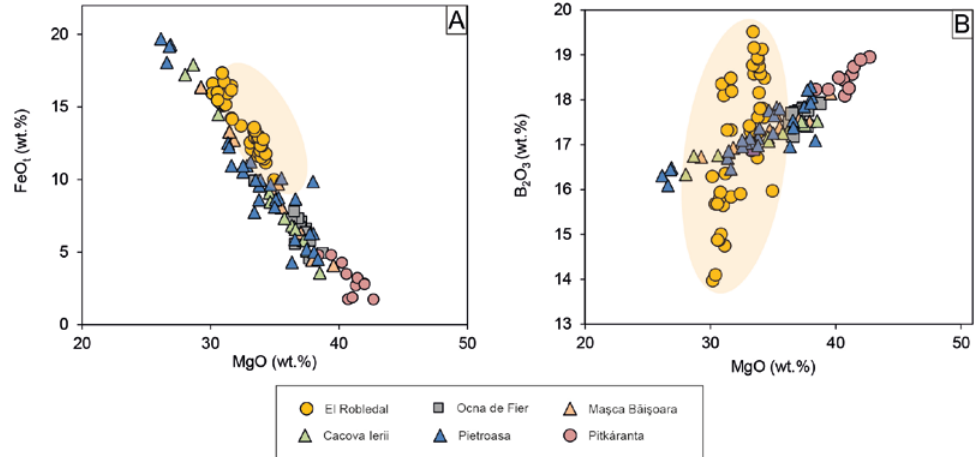
Figure 6. Binary plots showing EPMA results of ludwigite: ( A ) MgO vs. FeO t plot showing the high Fe content of ludwigite compared with similar Mg-skarn deposits; ( B ) MgO vs. B 2 O 3 plot showing the different trends of ludwigite composition in the El Robledal compared to ludwigite from other Mg-skarns deposits. The range of ludwigite composition from the El Robledal is highlighted with an orange-colored area. Data sources: (1) Ocna de Fier [14,56]; (2) Maşca Băişoara [14,54]; (3) Cacova Ierii [7,14]; (4) Pietroasa [14,54]; (5) Pitkáranta [57]. Mg-rich magnetite and magnetite are widespread throughout the whole